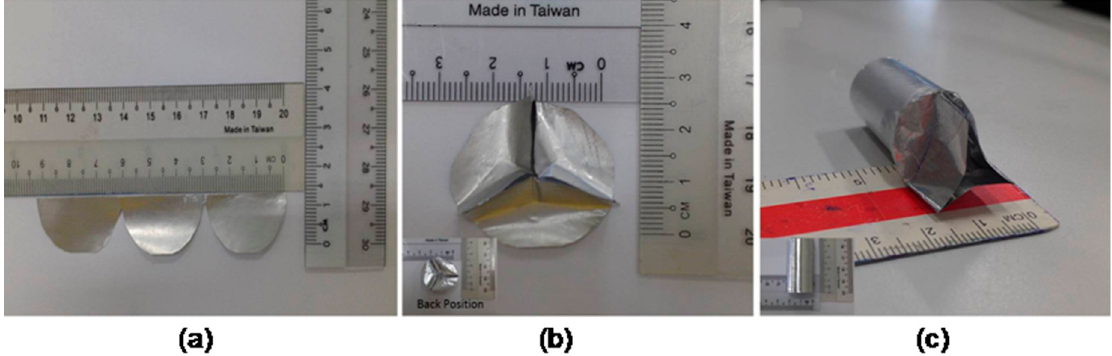
Figure 1. Design procedure of aluminum based 3D template to be used as the collector: ( a ) cutting the aluminum foil into the leaflets shape; ( b ) closing position form of the valve by folding the free-edge length; and ( c ) attaching the leaflets over a cylindrical tube.